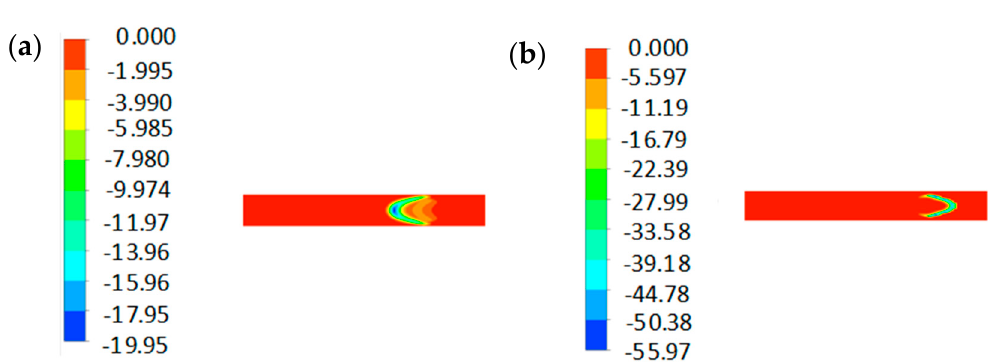
Figure 3. Pyrolysis ( a ) and oxidation ( b ) rate distribution of the tobacco area.